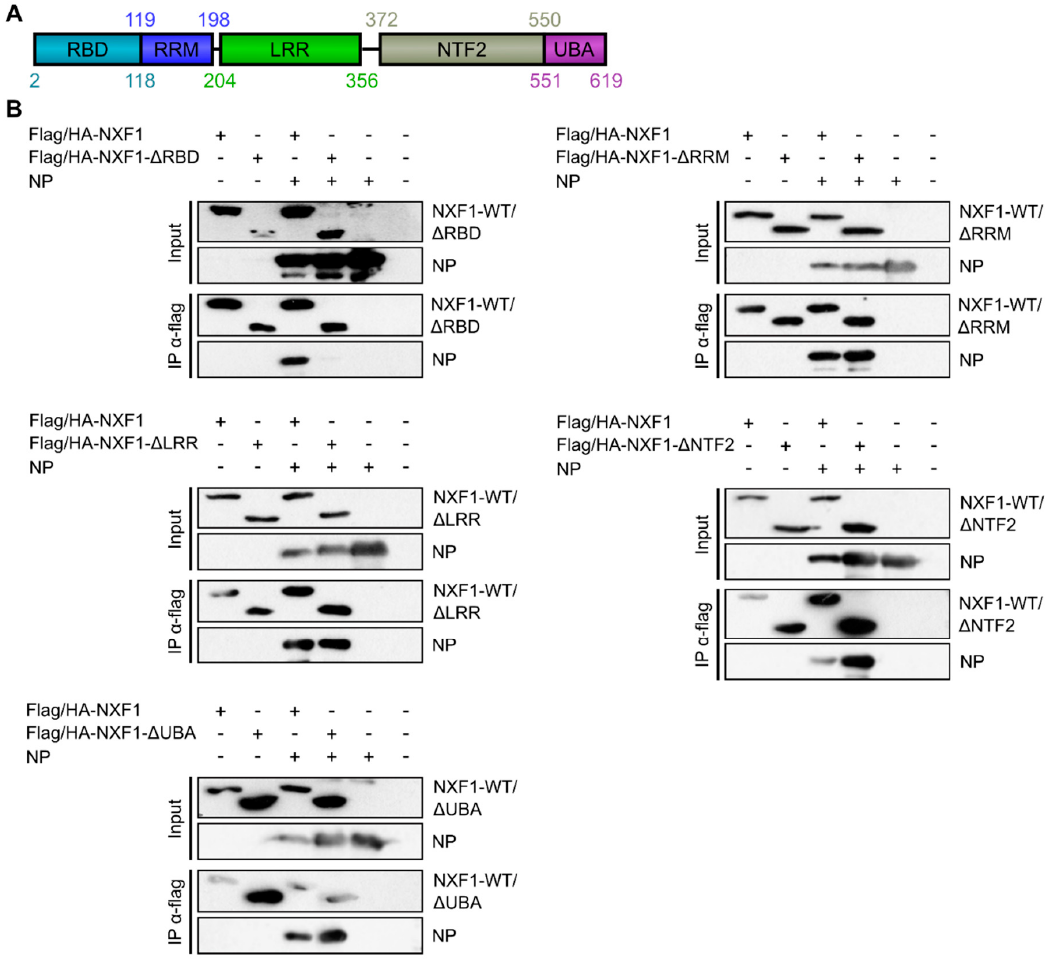
Figure 3. Identification of NXF1 domains necessary for the interaction with NP. ( A ) Domain organization of NXF1. Numbers indicate amino acid positions. ( B ) The RNA-binding domain of NXF1 is essential for its interaction with NP. 293T cells were transfected with plasmids encoding flag/HA-NXF1 or flag/HA-tagged NXF1 mutants together with NP. Forty-eight hours p.t., immunoprecipitation was performed using anti-flag antibodies. Subsequent SDS-PAGE and Western blot analyses with input and precipitates were performed using anti-flag and anti-NP